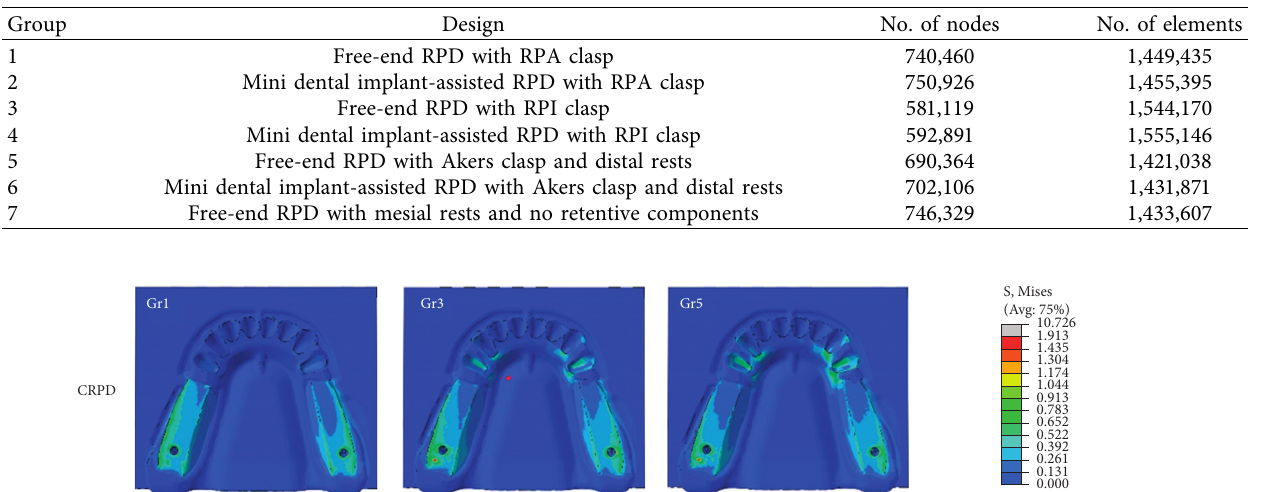
Table 2: Finite element models.